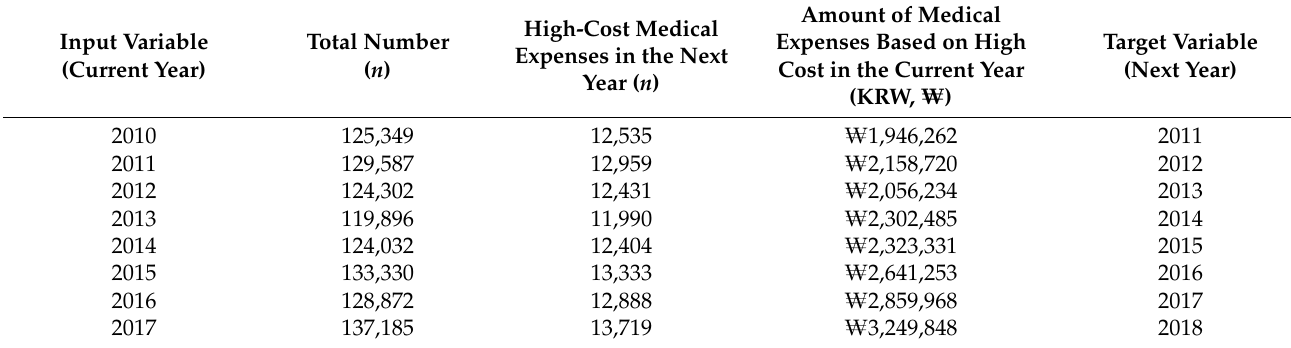
Table 2. Composition of the analytics